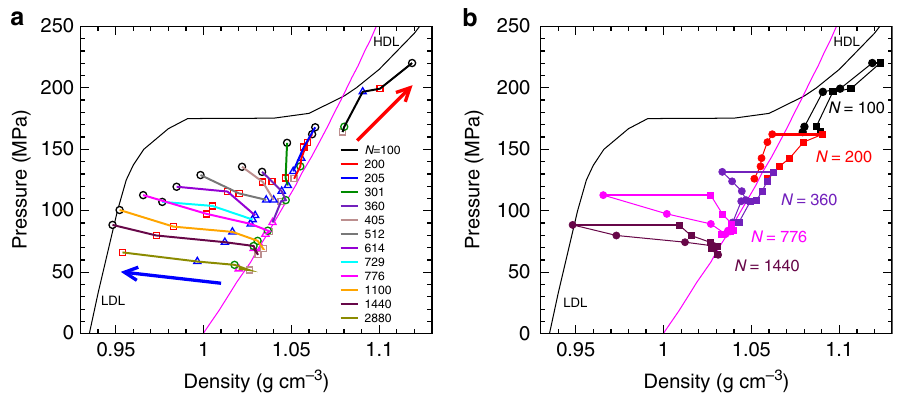
Fig. 8 Variation of density and pressure with temperature inside nanodroplets of various sizes. a Same data as in Fig. 3a for P L versus ρ c , except here data points with the same N are connected by coloured lines as indicated in the legend. Symbol types have the same meaning as in Fig. 3a. Error bars are omitted for clarity. The blue and red arrows indicate the direction of decreasing T along a curve of constant N . Note that for large N , lines of constant N are nearly isobaric, whereas as N becomes small, strong deviations from isobaric behaviour are observed. b P L versus ρ c (circles), and P L versus ρ s (squares) for droplets of various N . Note that T varies along each curve, from 280 to 180 K (for N = 360, 776, and 1440) and from 260 to 180 K (for N = 200 and 100). Data points for ρ c and ρ s at 180 K with the same N are joined by a thick horizontal line, to highlight their difference at low T . In both a and b , isotherms of P versus ρ for the bulk liquid are shown for T = 180 K (thin black line) and 280 K (thin magenta line). The branches of the 180 K bulk isotherm corresponding to LDL and HDL are indicated.